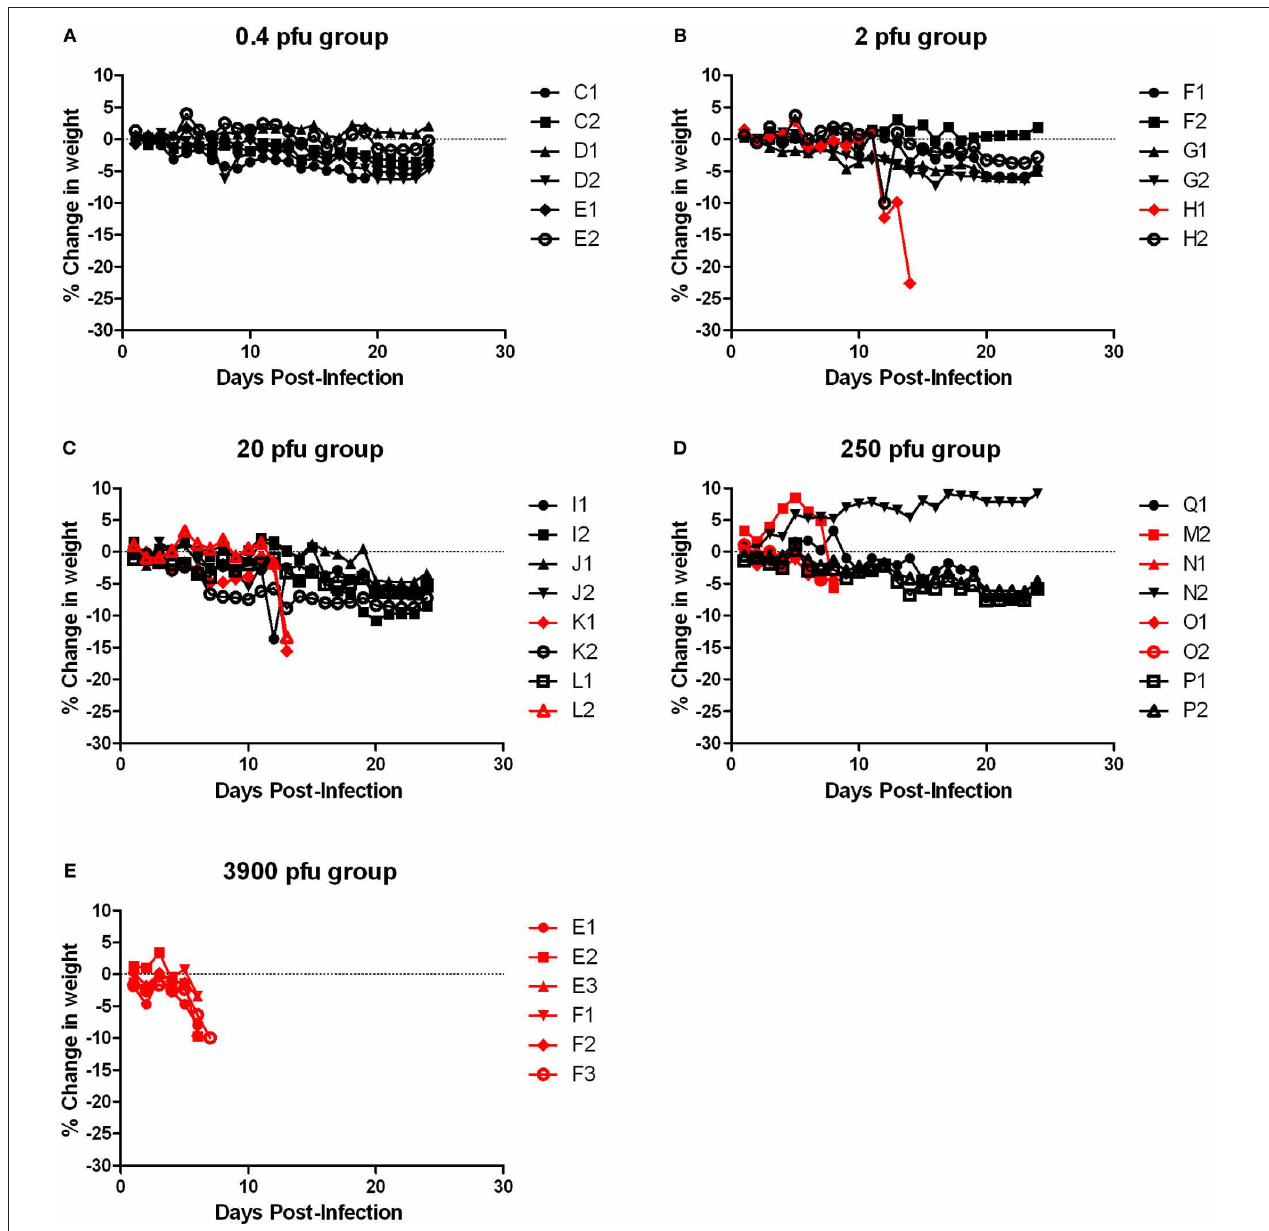
FIGURE 5 | Body weight of ACI rats infected with aerosolized RVFV. Groups of six to eight female ACI rats were infected with RVFV by the aerosol route at five doses plus uninfected controls. (A) 0.4pfu/rat; (B) 2pfu/rat; (C) 20pfu/rat; (D) 250pfu/rat; (E) 3900pfu/rat. The y -axis